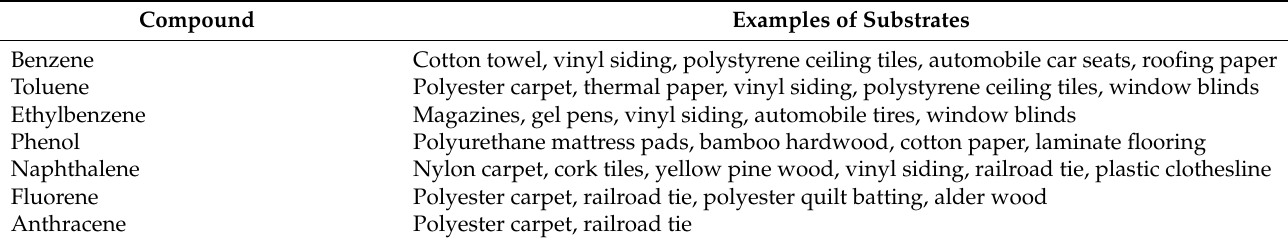
Table 2. Examples of substrates from the Substrate data containing priority pollutant compounds that were contained in 10% or more of the ILRC and/or Substrate Database